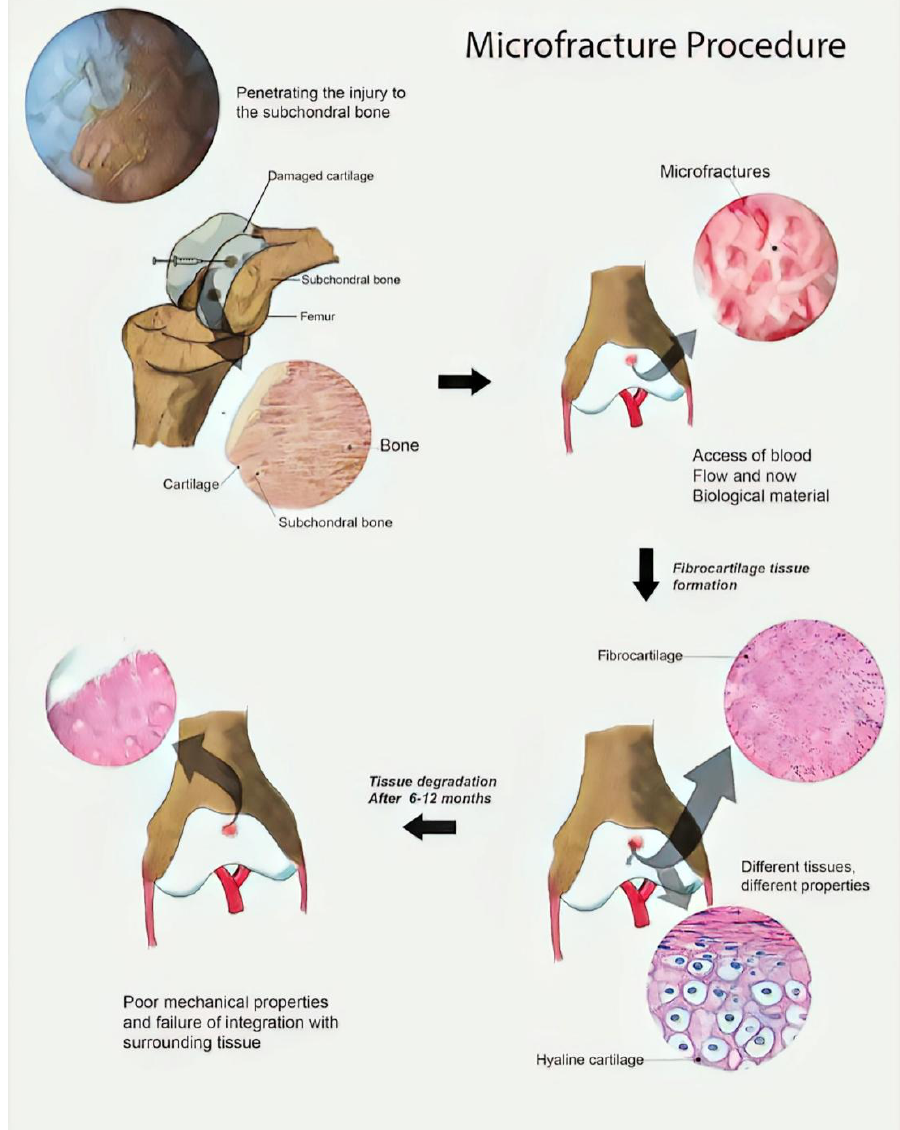
Figure 1. Common clinical procedure used to heal cartilage injury. Original illustration designed and provided by the authors.